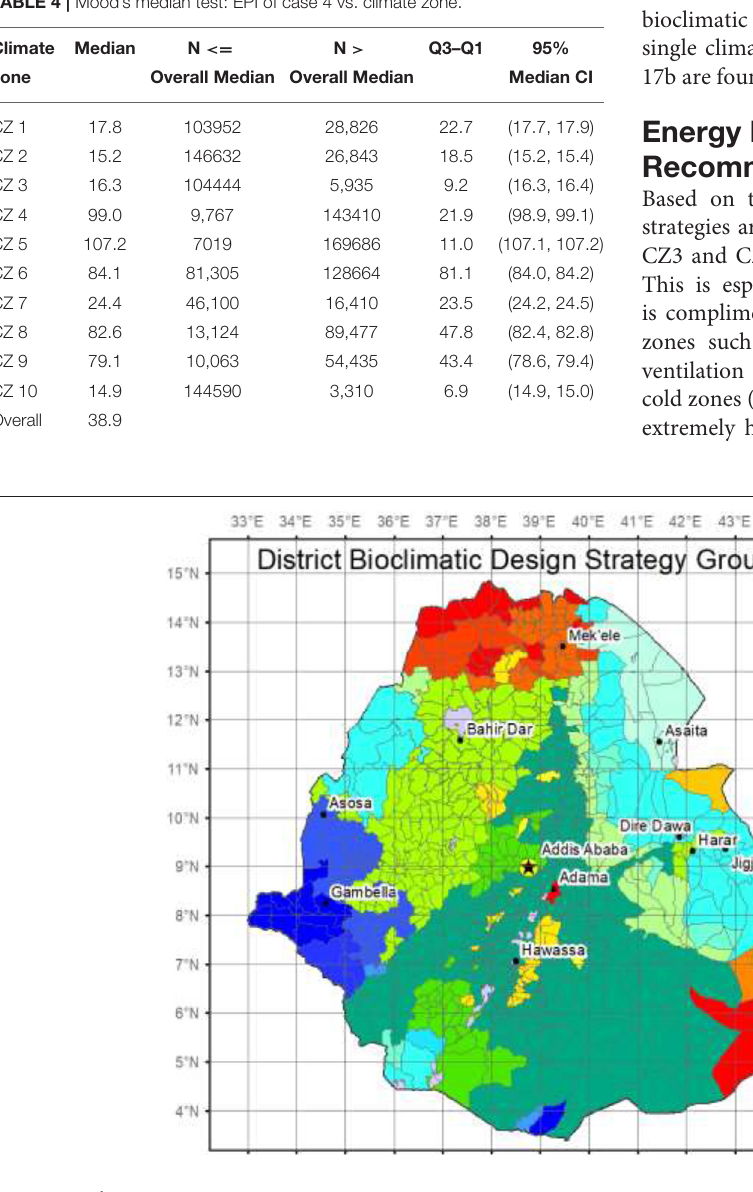
Frontiers in Sustainable Cities |